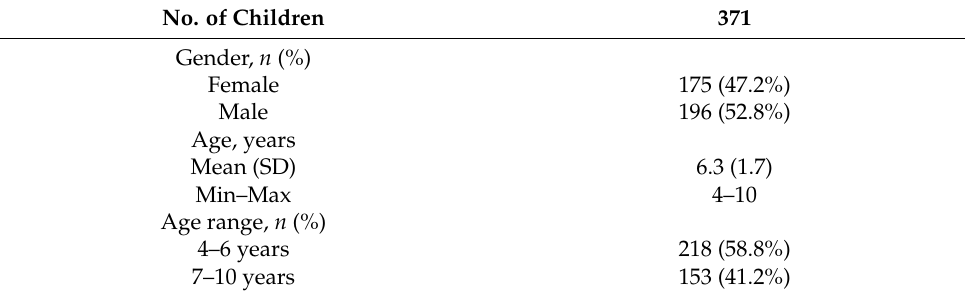
Table 1. Patient